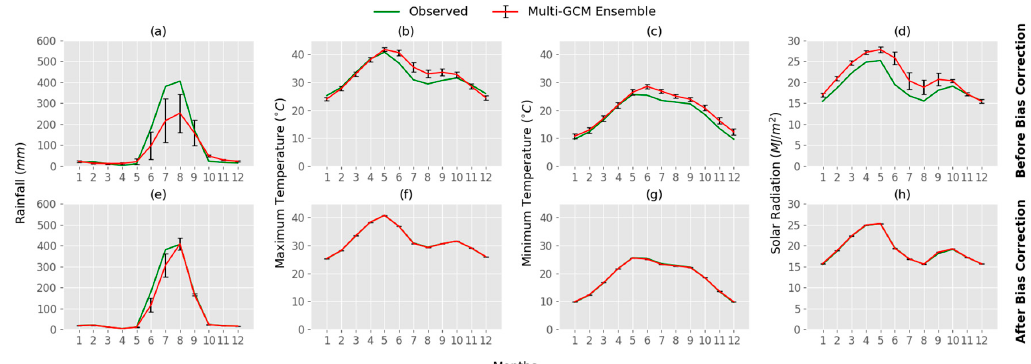
Figure 4. Comparison of observed and multi-GCM ensemble (error bars represent variability among the five GCMs) time series of 1990s for before and after bias correction of ( a ) rainfall, ( b ) maximum temperature, ( c ) minimum temperature, and ( d ) solar radiation at a randomly selected grid (latitude 23.0 and longitude 80.0).